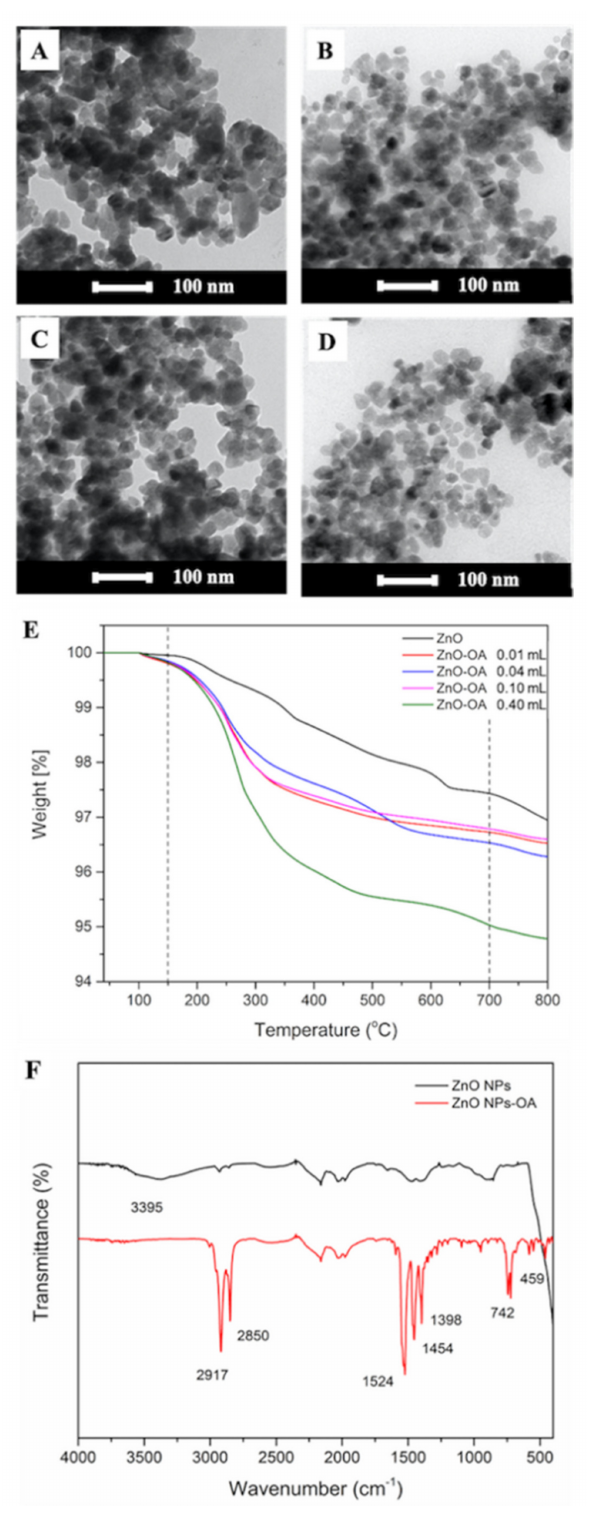
Figure 1. TEM images ( A – D ), TGA thermogram ( E ) of OA-ZnO NPs using the added OA content of 0.01, 0.04, 0.10, and 0.4 mL, and ( F ) FTIR spectra of bare ZnO and OA-ZnO NPs (4.8 wt%